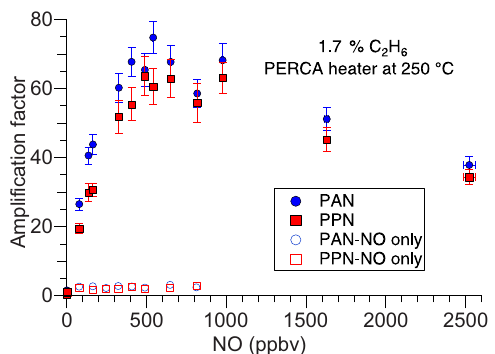
Figure 6. TD-PERCA-CRDS amplification factors of ∼ 0.5ppbv PAN and ∼ 1.3ppbv PPN as a function of NO mixing ratio at RH = 0%. The error bars represent standard deviations of 1s